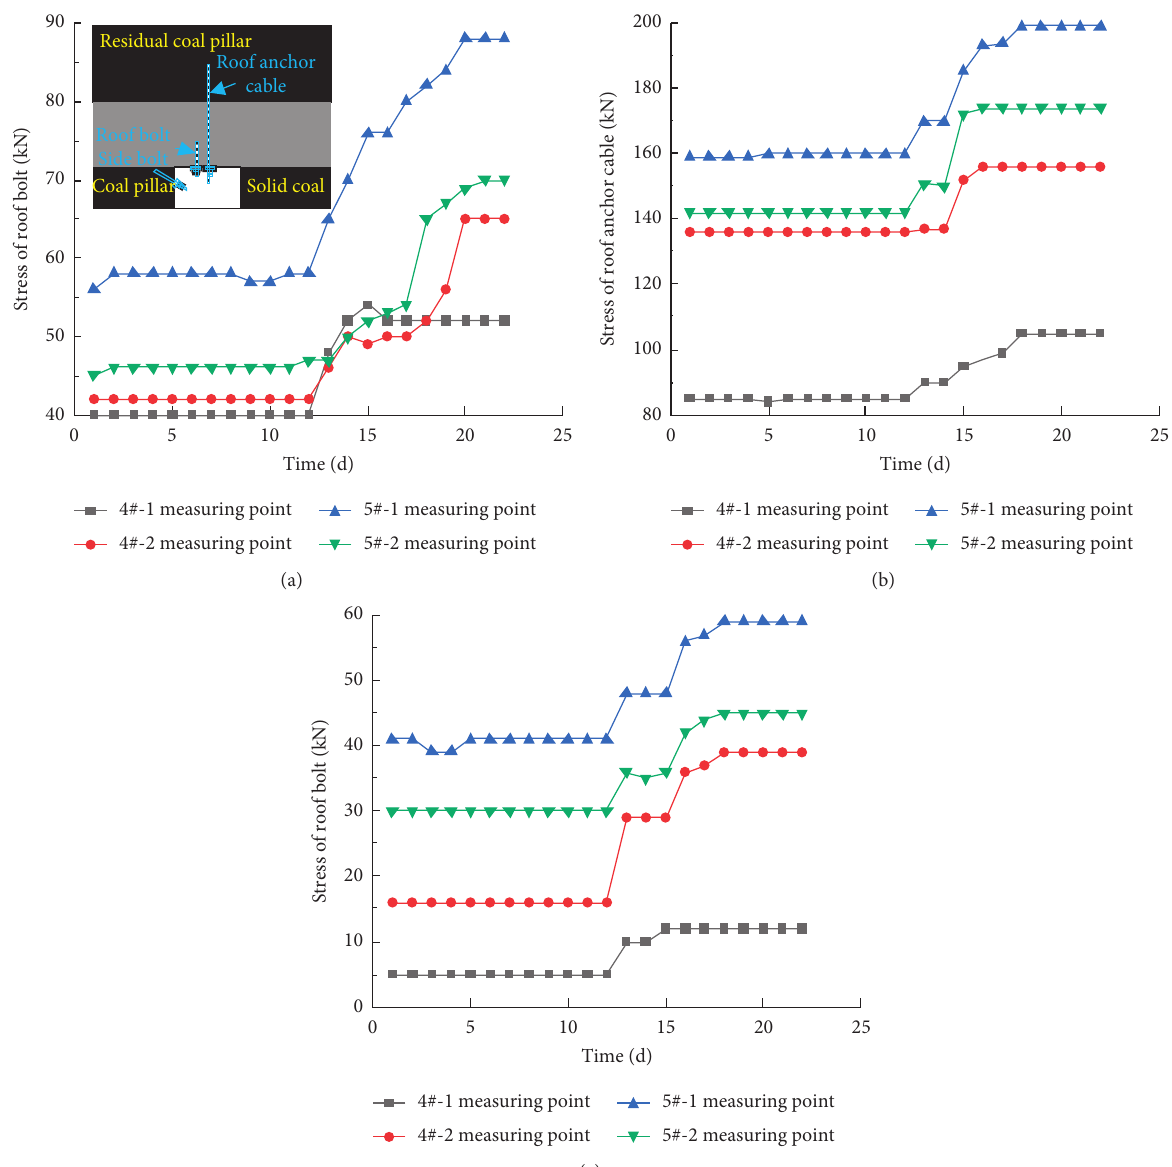
Figure 9: Stress curve of the anchorage body: (a) stress of the roof bolt; (b) stress of the roof anchor cable; (c) stress of the side